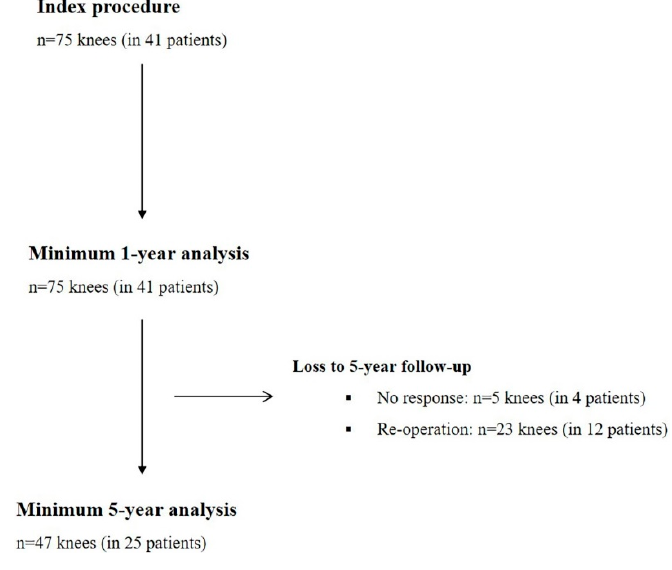
Figure 1. Study cohort.